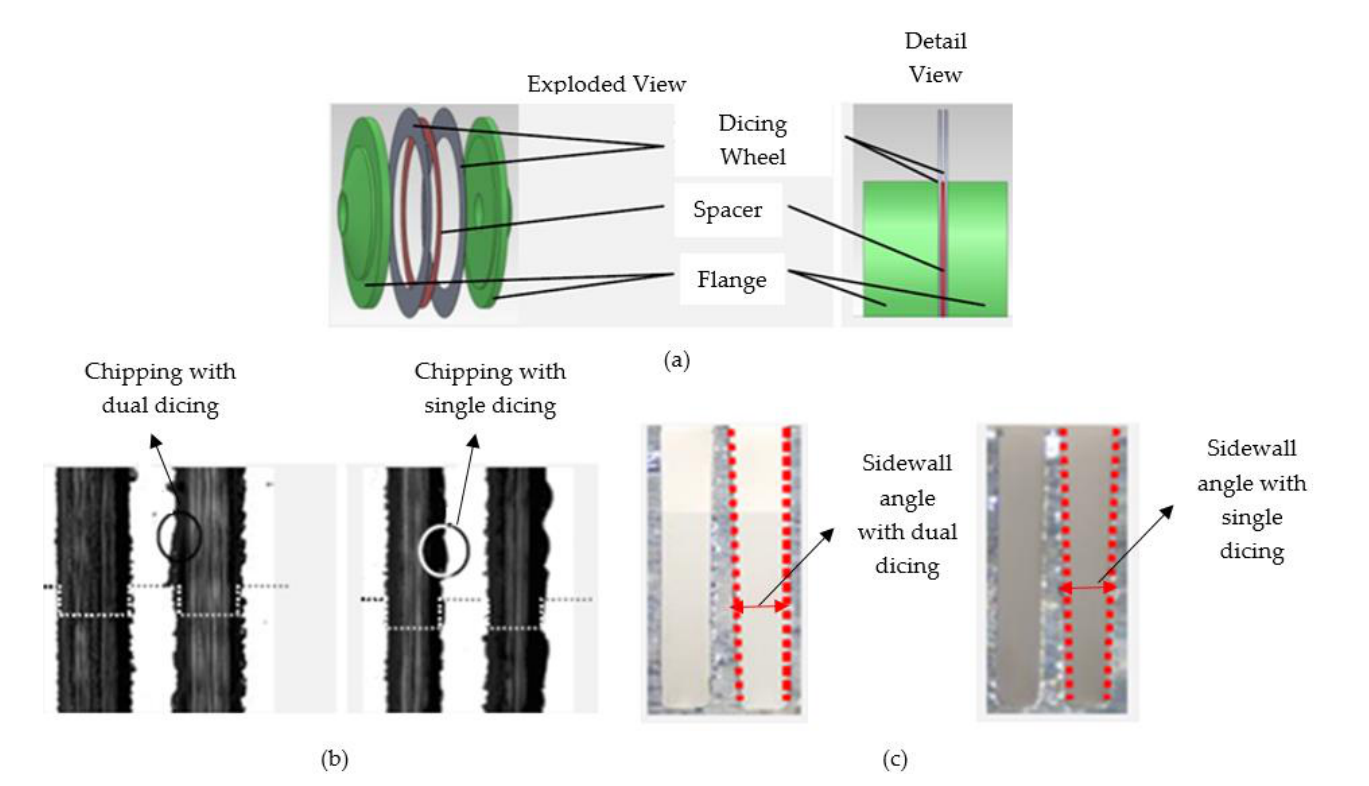
Figure 9. ( a ) Concept of dual dicing; silicon dicing results comparing single and dual dicing for ( b ) chipping ( c ) sidewall angles [41]. Table 1. Components of three dicing blades